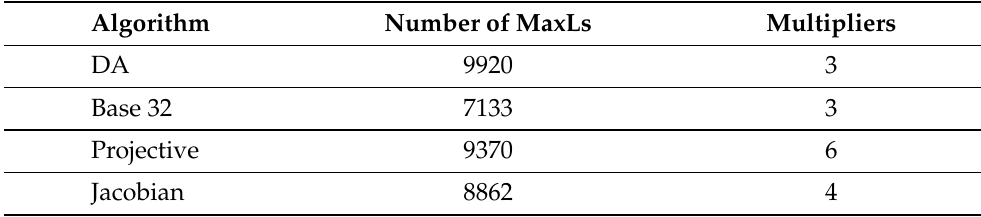
Table 8. The Number of Multipliers Appropriate to Achieve the Highest Level of Parallelism.